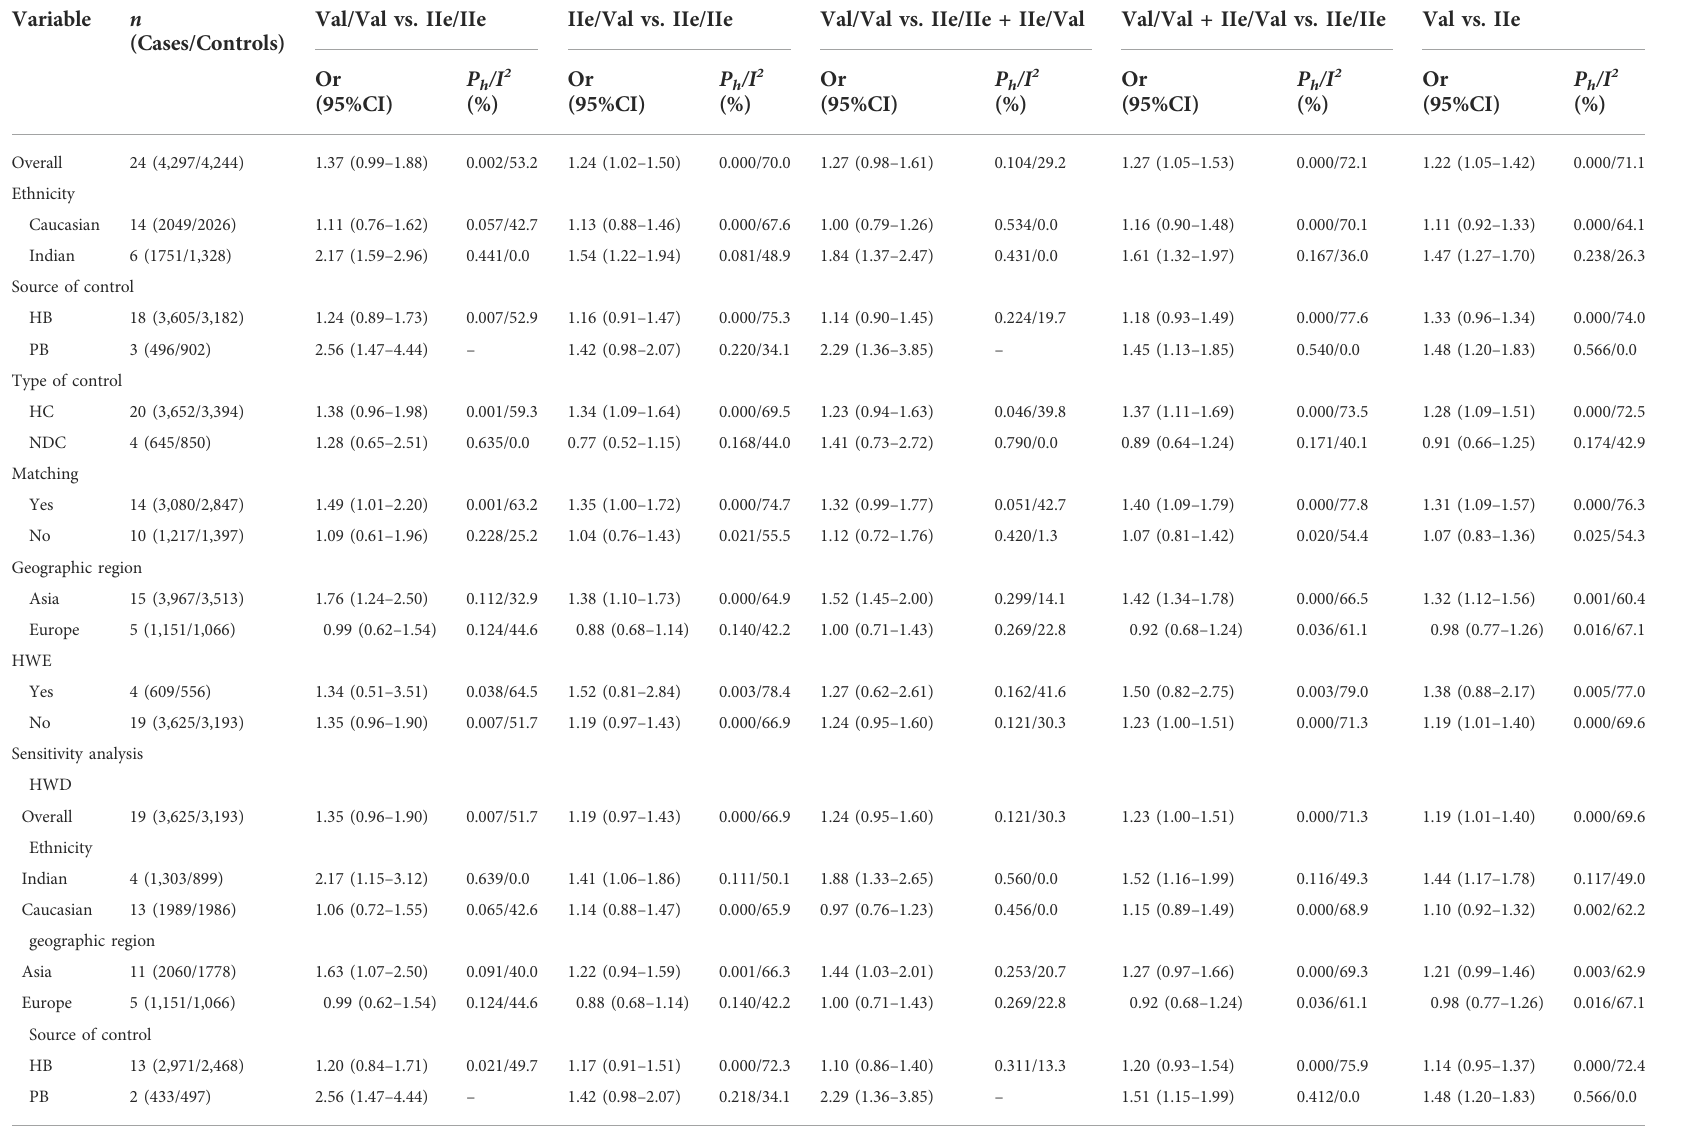
TABLE 3 Meta-analysis of the association of GSTP1 polymorphism with risk of